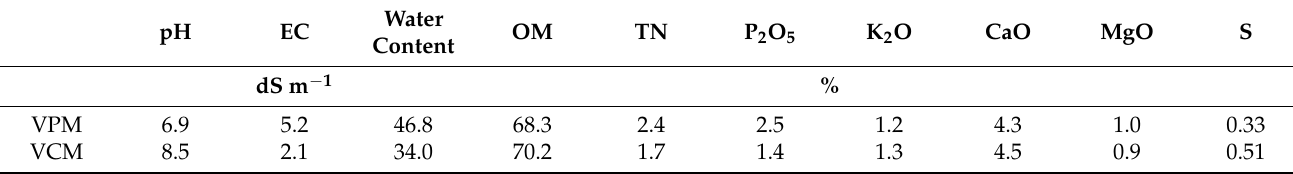
Table 1. The characteristics 1 of two vermicomposts 2